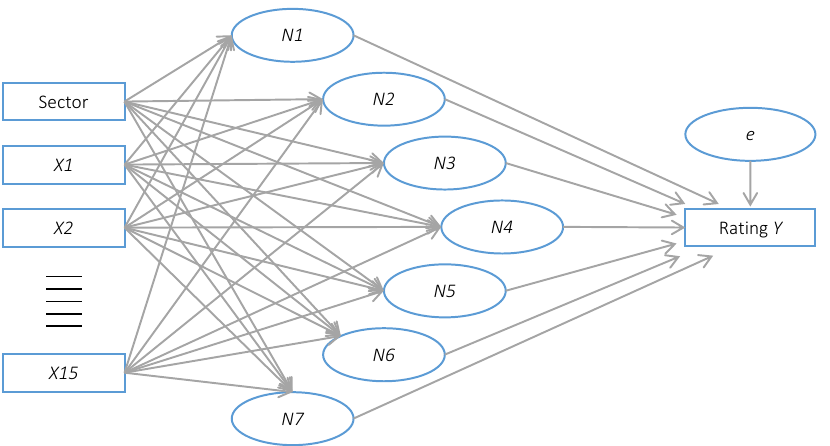
Figure 1. ANN estimated with sample I for S&P’s ratings